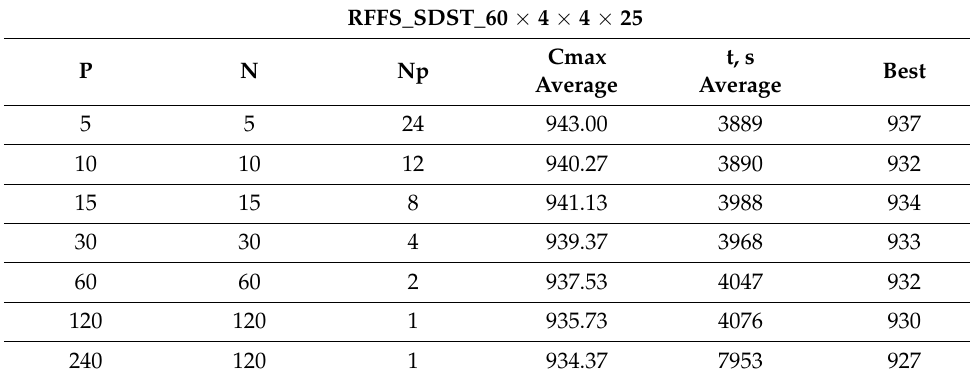
Table 9. RFFS_SDST_60 × 4 × 4 × 25